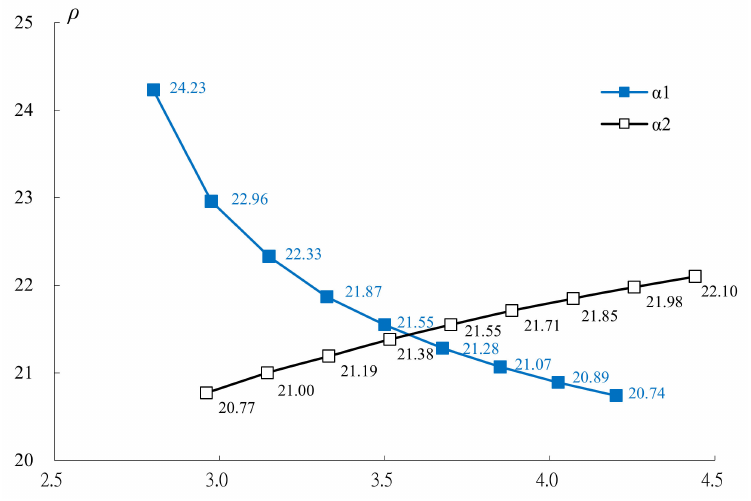
Figure 6. E ff ect of α 1 and α 2 on ρ